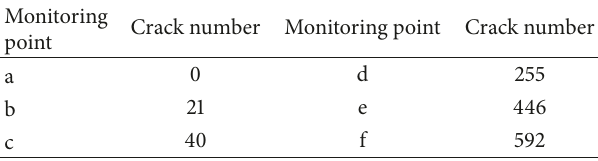
Table 5: Number of cracks in the specimen at different monitoring